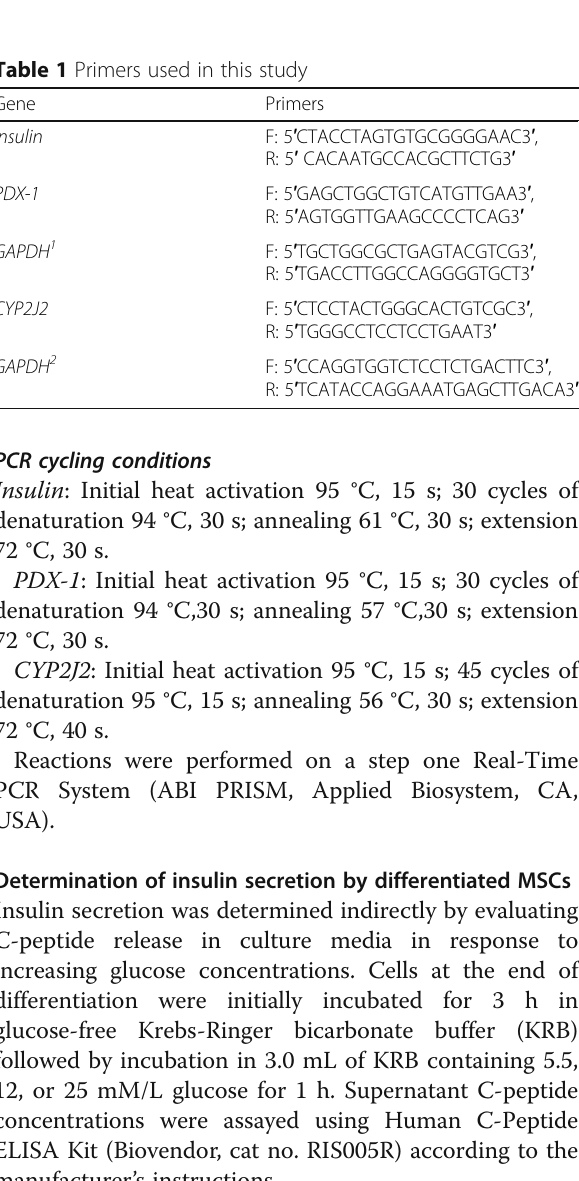
Table 1 Primers used in this study Gene